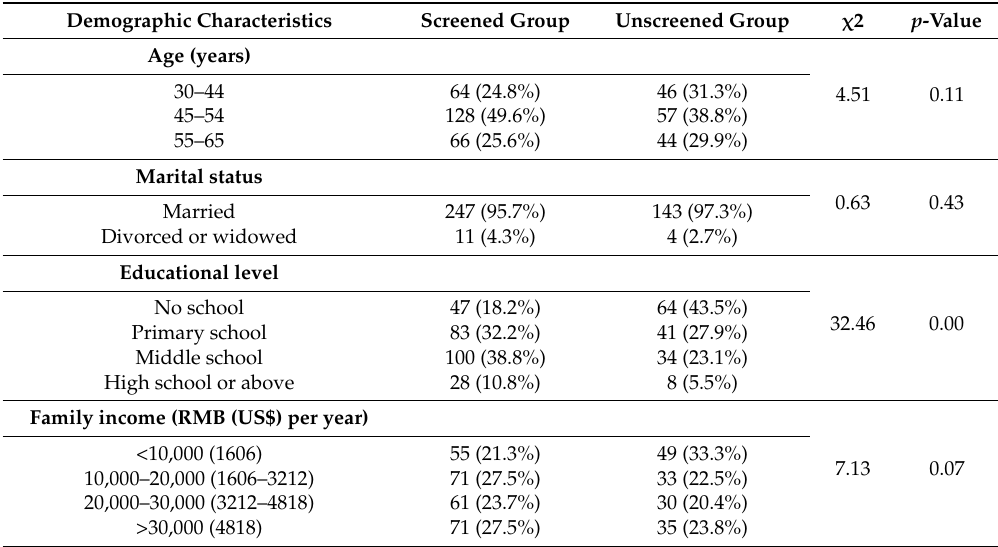
Table 2. Socio-demographic characteristics between screened and unscreened groups, n